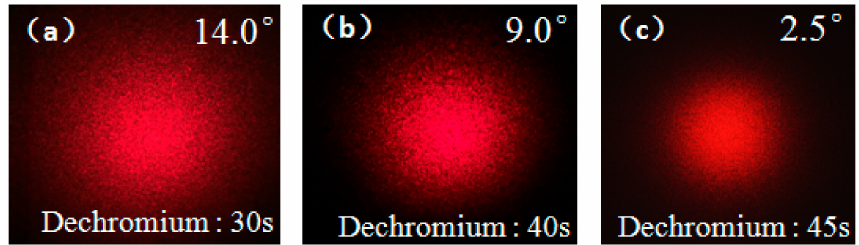
Figure 11. The scattering speckle patterns produced by the structures with different dechromium times: ( a ) 30 s; ( b ) 40 s; ( c ) 45